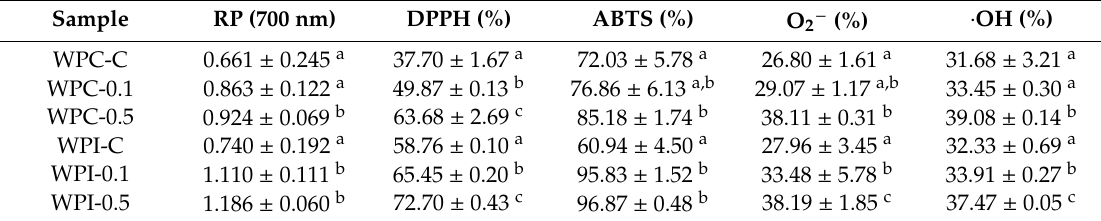
Table 4. Reducing power (RP) and radical (DPPH, ABTS, O 2 − , · OH) scavenging activity of neat WPC / WPI and melanin-modified